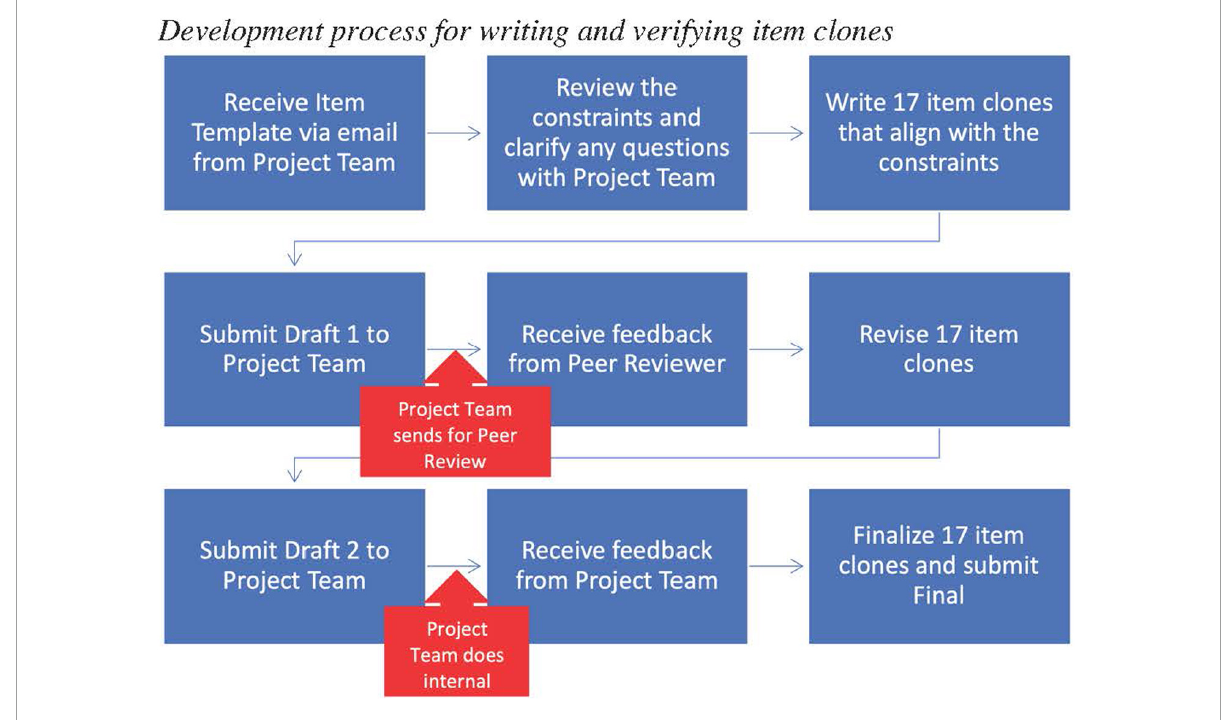
FIGURE8 Development process for writing and verifying item